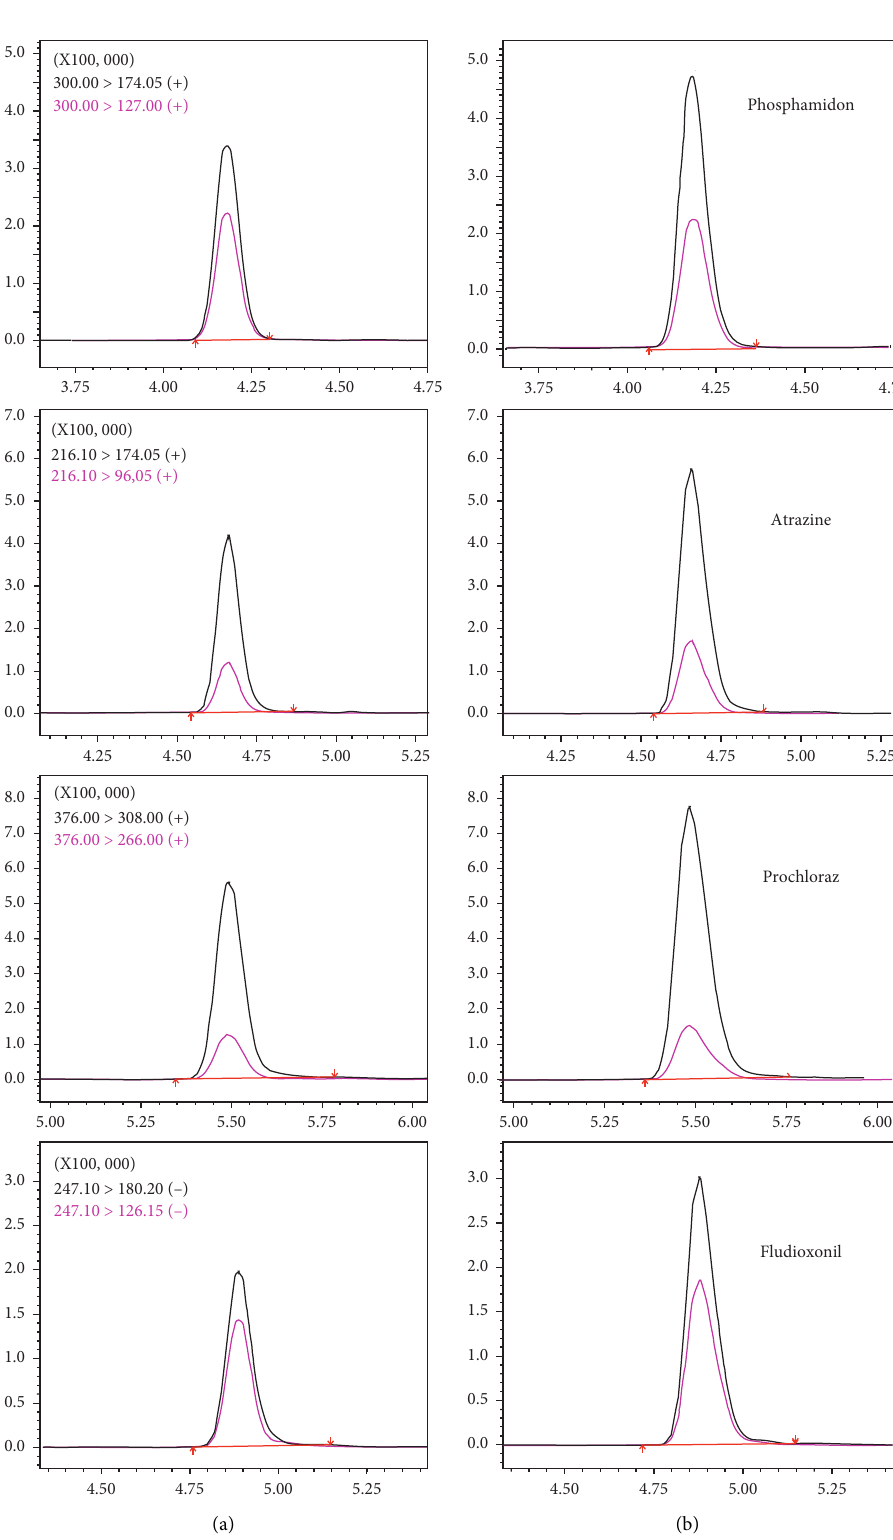
Figure 4: XIC chromatograms of four representative pesticides at 40 μ g/L in unpurified solution (a) and purified solution